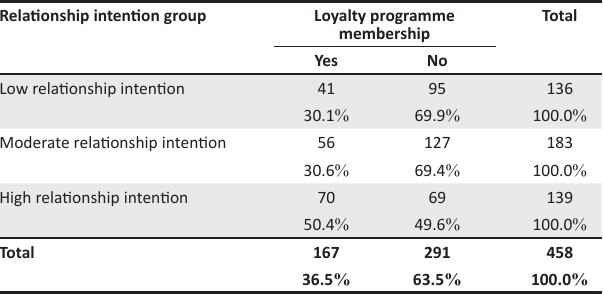
TABLE 5: Cross-tabulation between relationship intention groups and loyalty programme membership. Relationship intention group